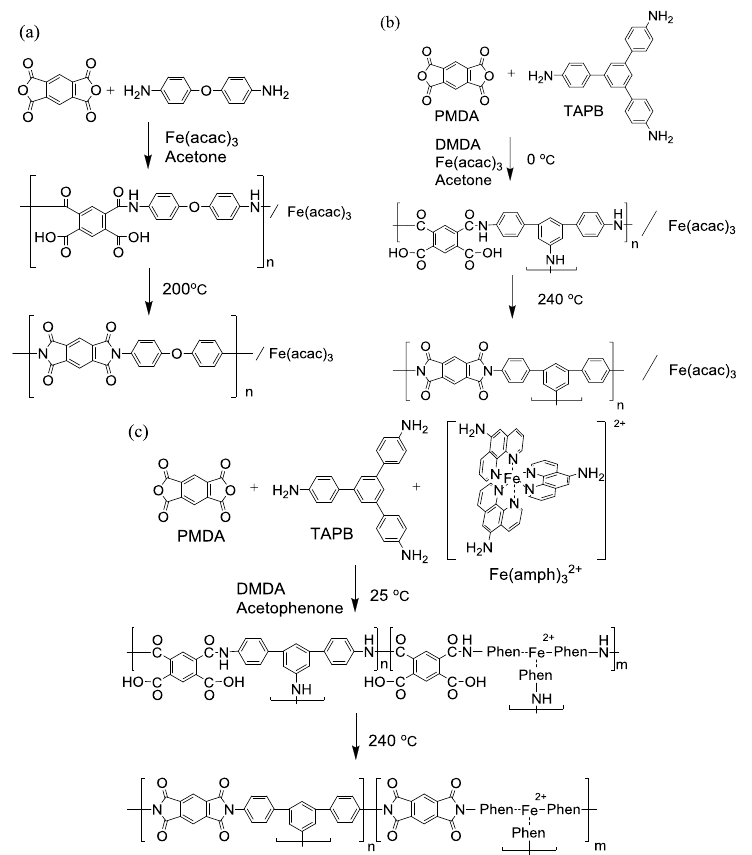
Figure 4. Synthetic routes of polyimide nano-particles of different sizes from ( a ) pyromellitic acid dianhydride (PMDA) and 4,4’-oxidianiline (ODA) (100–300 nm diameter); ( b ) PMDA and 1,3,5-tris(4-aminophenyl) benzene (TAPB) in the presence of a surfactant (60 nm diameter); and ( c ) PMDA, TAPB, and Fe(amph) 3 (uniform dispersion of Fe additive).